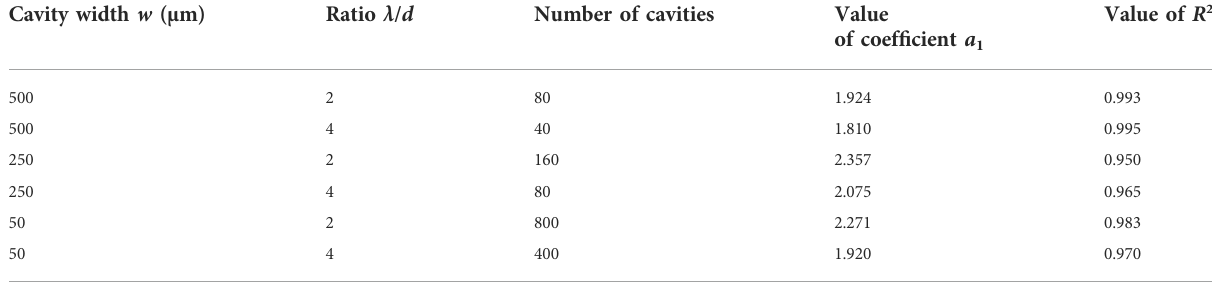
TABLE 3 Values of coef fi cient a in correlations for different roughness walls. Cavity width w ( μ